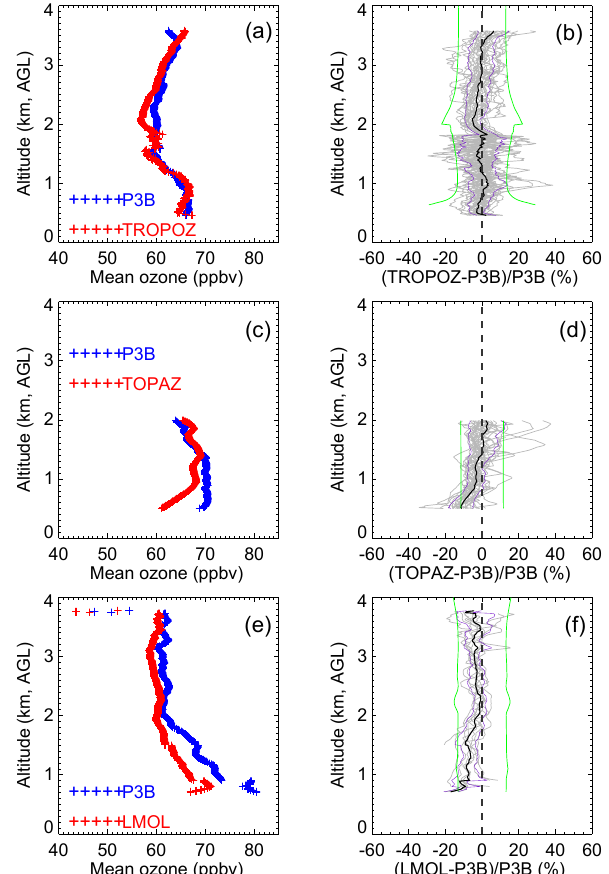
Figure 4. Intercomparison between the lidar and P-3B measure- ments. (a) Average ozone profiles measured by TROPOZ and P- 3B at Fort Collins, CO (34 profiles). (b) Mean relative difference (black) between TROPOZ and P-3B data as well as the 1 σ standard deviation (purple). (c) Average ozone profiles measured by TOPAZ and P-3B at the BAO tower (29 profiles). (d) Mean relative differ- ence between TOPAZ and P-3B data as well as the 1 σ standard deviation (purple). (e) Average ozone profiles measured by LMOL and P-3B at Golden, CO (9 profiles). (f) Mean relative difference between LMOL and P-3B data as well as the 1 σ standard devia- tion (purple). The gray lines represent the individual difference pro- files between the lidar and sondes. The green lines represent the expected, uncertainties including the 30min lidar measurement un- certainties (also see Table 2) and a 10% constant uncertainty for